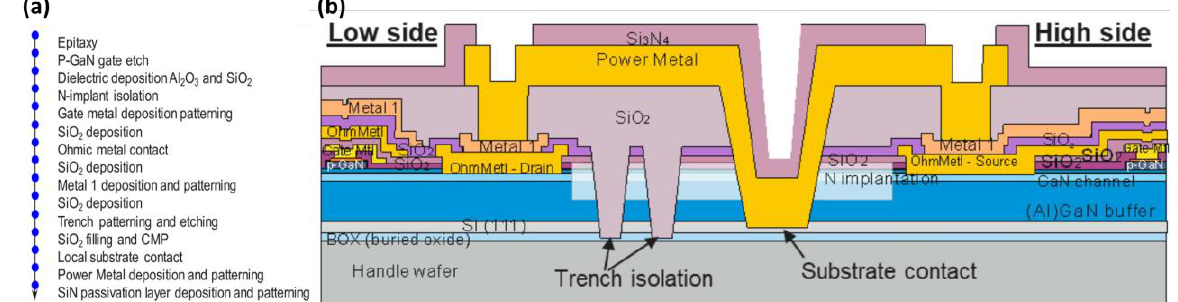
Figure 7. ( a ) Schematic cross-section of the epitaxial layer stack and process integration flow. ( b ) Schematic cross-section of the integrated half-bridge, trench isolation, and local substrate contact [128]. Figure reproduced with permission from IEEE Transactions on Semiconductor Manufacturing.